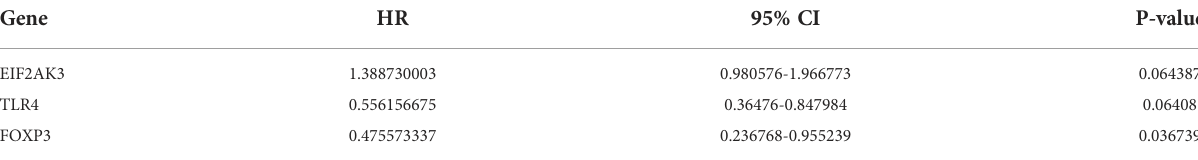
TABLE 1 Multivariate Cox regression analysis of three ICD-related genes associated with OS patients ’ prognosis. Gene HR